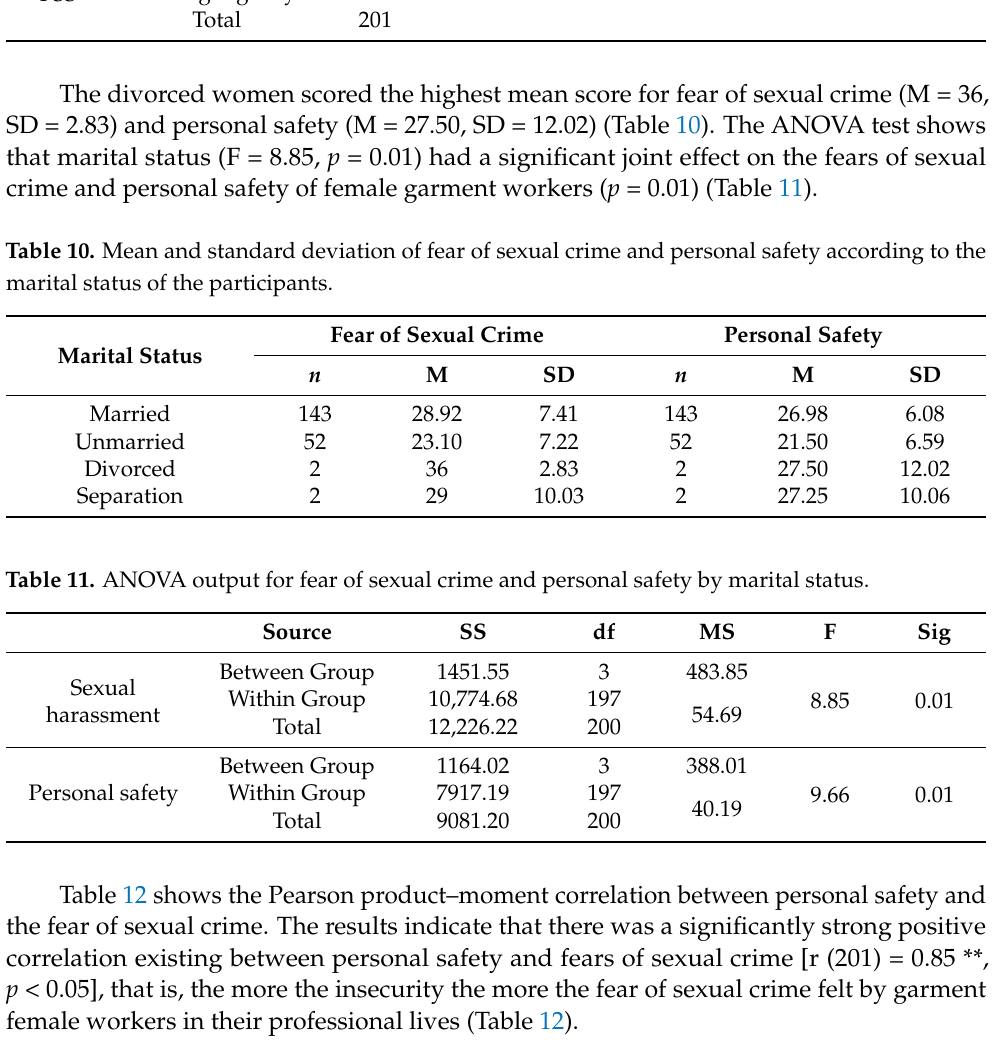
Table 12. Correlation between personal safety and fear of sexual crime. Variable Fear of Sexual Crime Personal Safety 0.85 ** ** p <